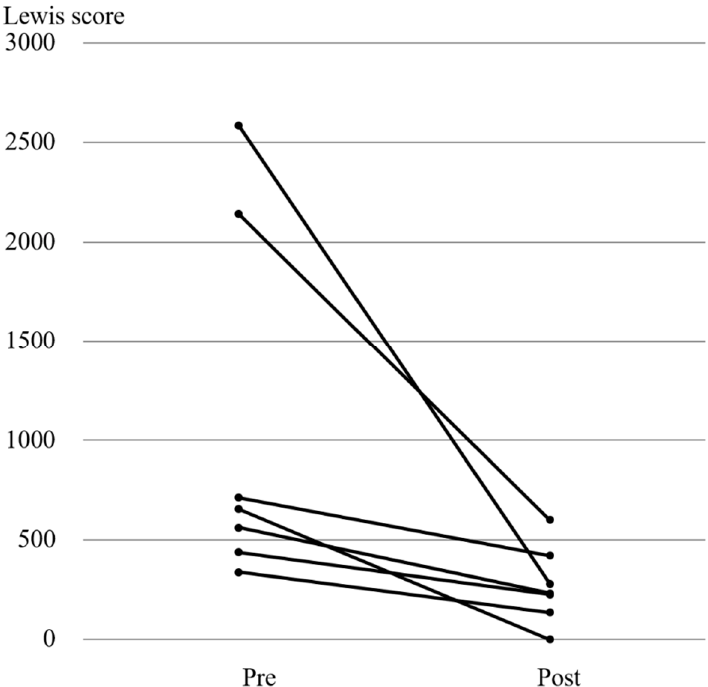
Figure 3. Changes in the Lewis scores in patients who received biologics as additional treatment. Abbreviations Pre, pre-treatment; post, post-treatment.